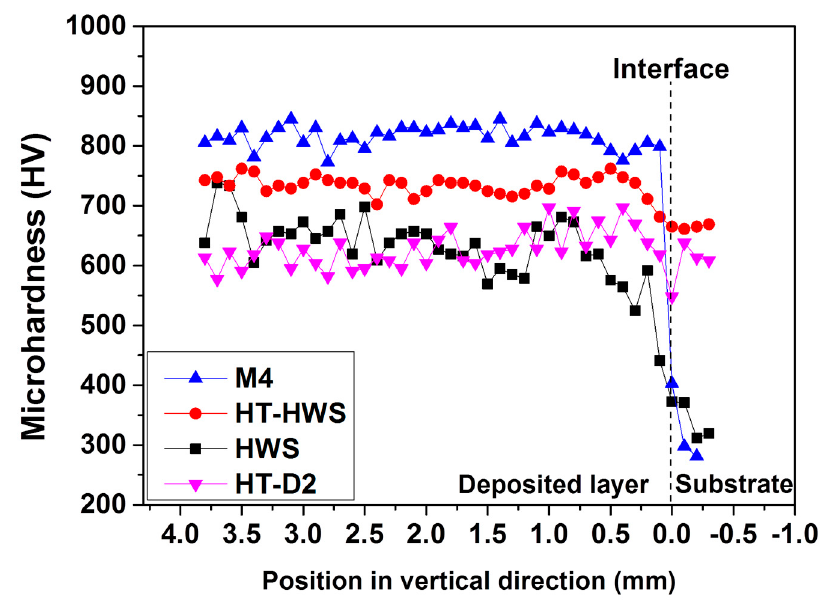
Figure 7. Distribution of micro-hardness measured from the top surface of the deposited region to the substrate.